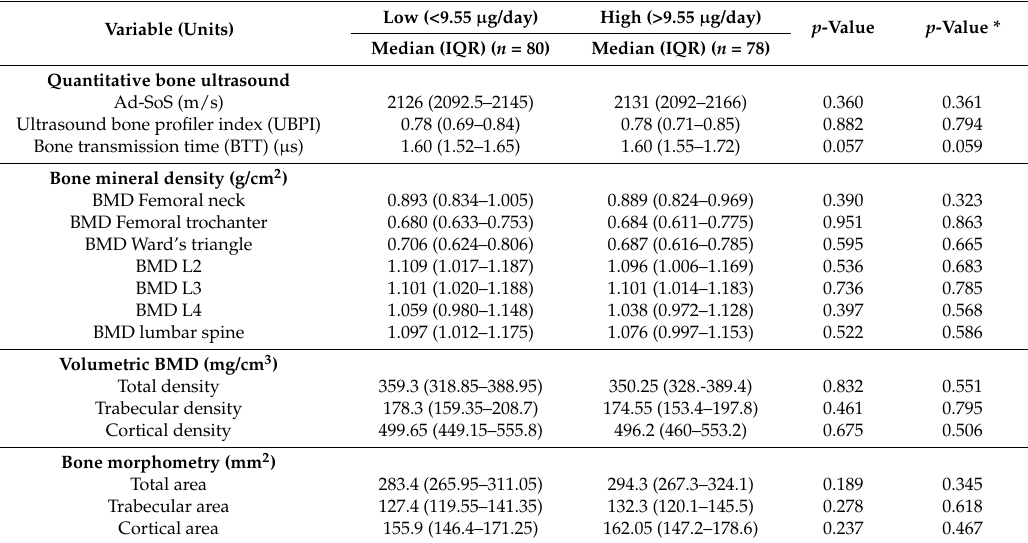
Table 6. Bone density and mercury dietary intake in premenopausal women. Variable (Units)